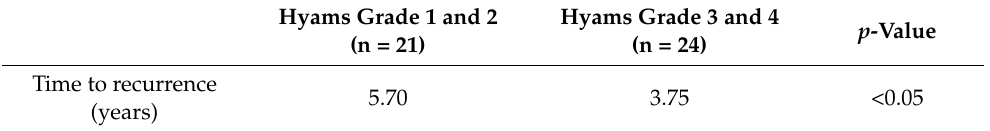
Table 3. Hyams grade and Kadish stage relation to recurrent time and local recurrence.